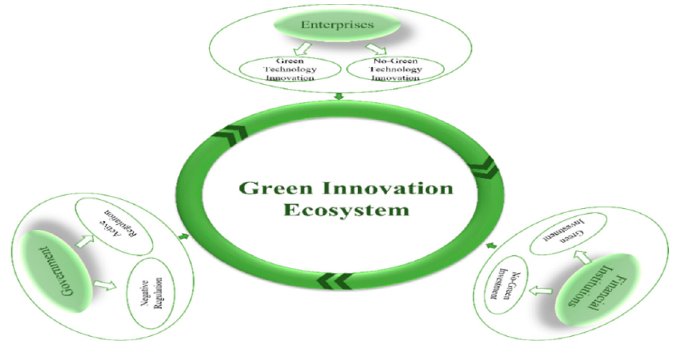
Figure 2. Enterprise green innovation ecosystem. Hypothesis 2. The basic income of new energy enterprises when they choose traditional technology